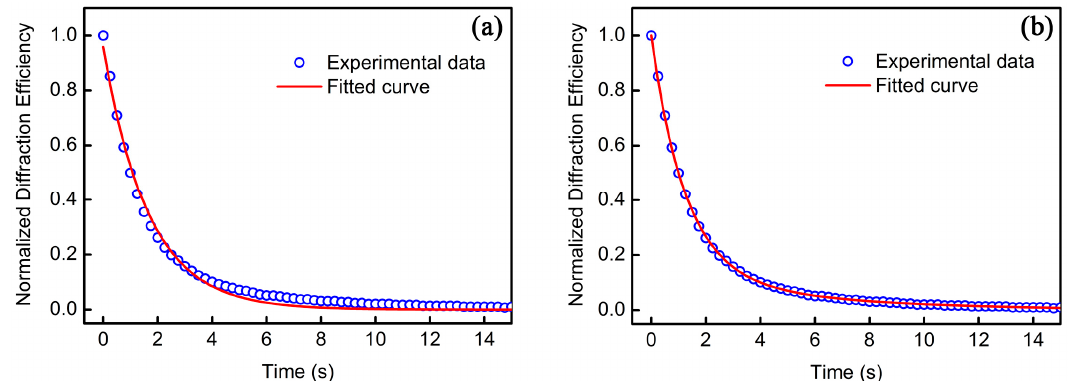
Figure 4. The normalized erasing curves of CLN 100 at 351 nm: ( a , b ) curves fitted by mono-exponential function and double-exponential functions, respectively. The circles represent experimental data and the solid are fitted curves.